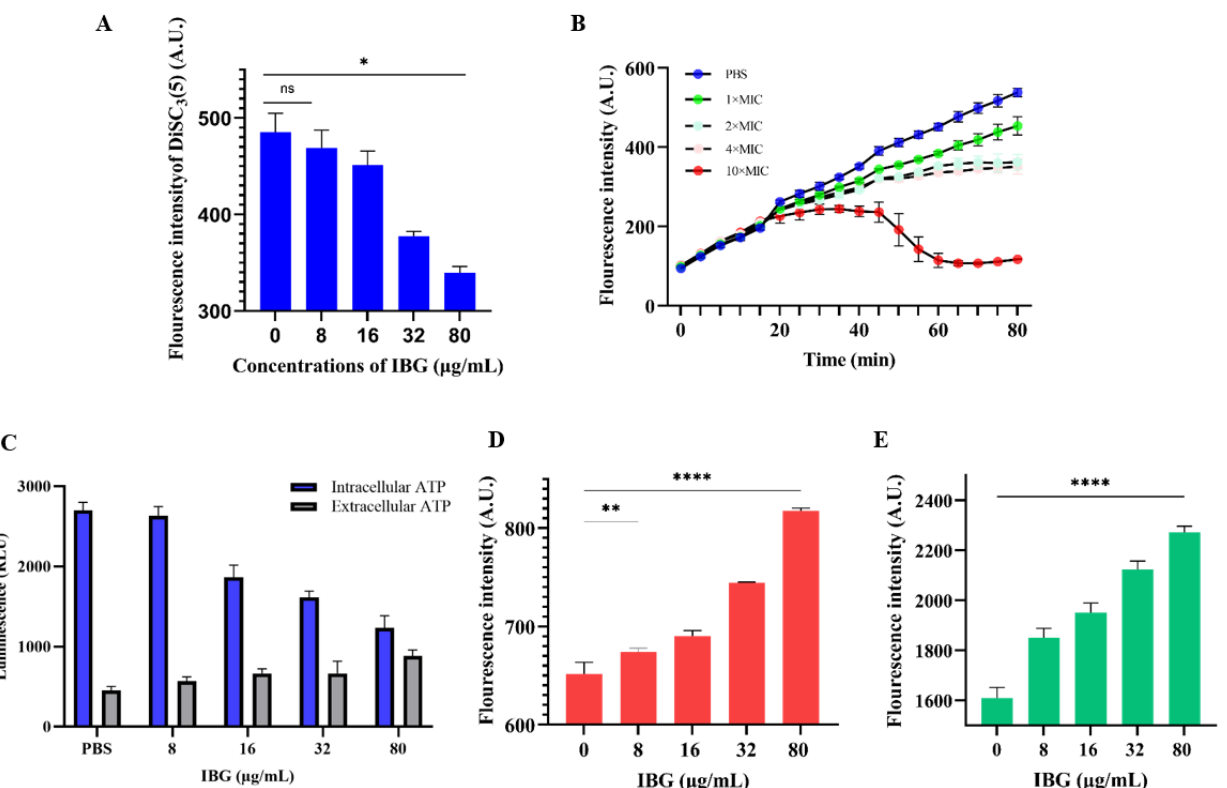
Figure 2. The antibacterial mechanism of IBG against Streptococcus suis. ( A ) Fluorescent probe DiSC 3 (5) was used to detect the membrane potential ( ΔΨ m). Disruption of membrane potential in IBG-treated S. suis ATCC 43765. p values were determined using a non-parametric one-way ANOVA. ( B ) The ∆ pH of S. suis ATCC 43765 treated with different concentrations of IBG was detected by the fluorescent probe BCECF-AM. ( C ) The intracellular and extracellular ATP levels of IBG-treated S. suis ATCC 43765. ( D ) The effect of low concentrations of IBG on ROS accumulation in S. suis ATCC 43765 was negligible. ( E ) The permeability of S. suis ATCC 43765 membranes was probed by PI. 1 × MIC, 8 µg/mL; 2 × MIC, 16 µg/mL; 4 × MIC, 32 µg/mL; and 10 × MIC, 80 µg/mL. *, p < 0.01, ****, p < 0.0001.